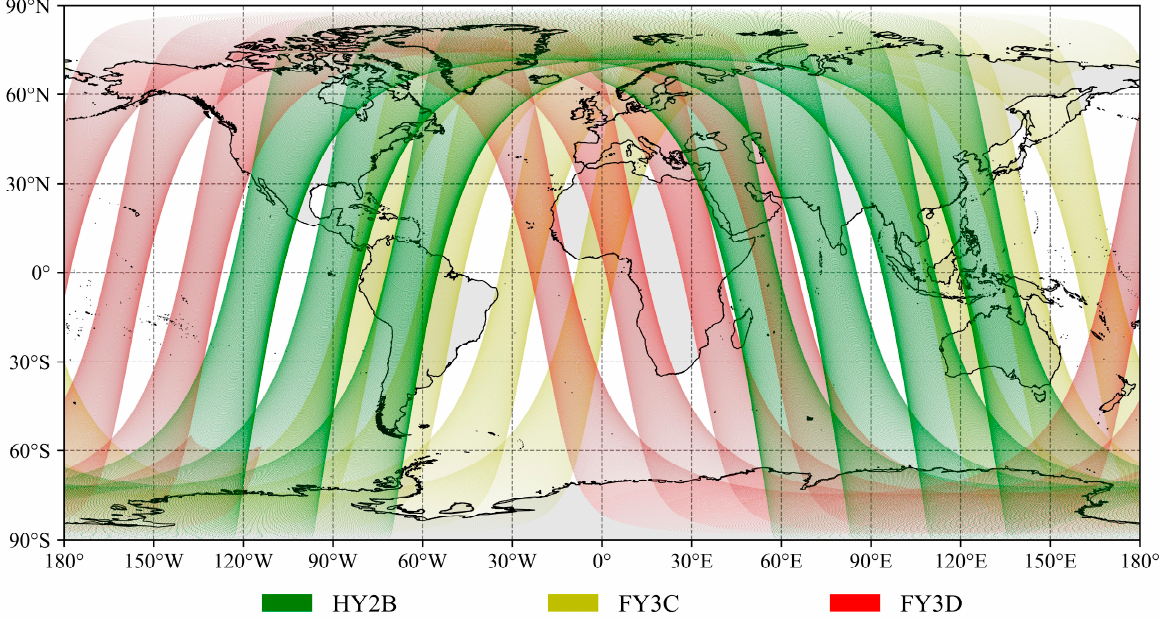
Figure 1. Observations of the three microwave imagers, including the SMR onboard HY-2B (green), the MWRI onboard FY-3C (yellow), and the MWRI onboard FY-3D (red) in the 6 h observation assimilation window at 1200 UTC.